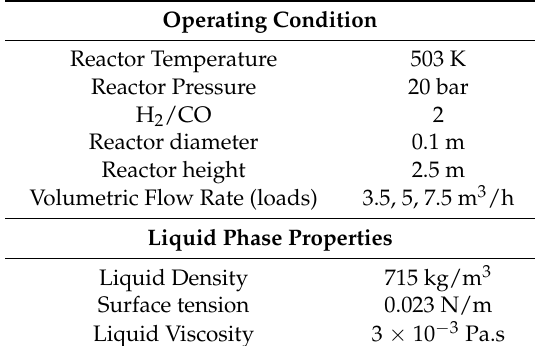
Table 2. Operating conditions and liquid properties of lab-scale Fischer–Tropsch Slurry Bubble